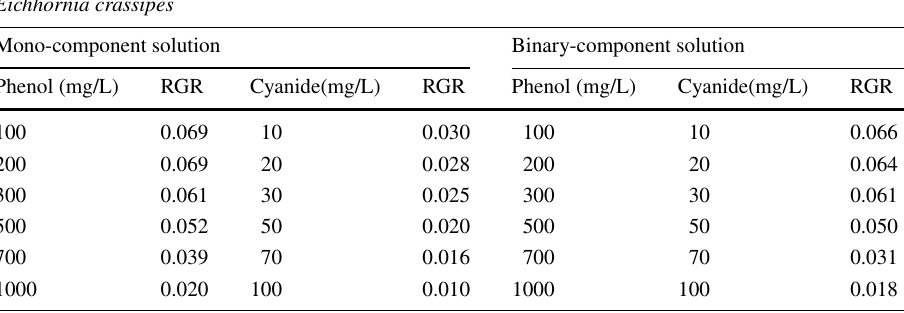
Table 3 RGR in plants after 13 days exposure to phenol and cyanide in mono and binary component solution